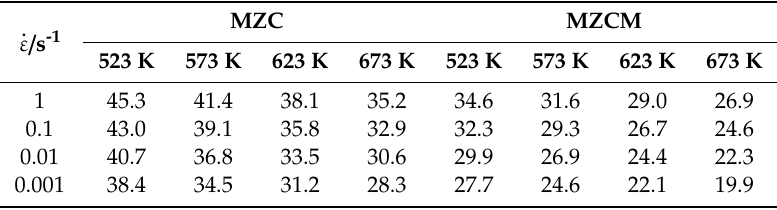
Table 5. lnZ values of MZC and MZCM under di ff erent deformation conditions.